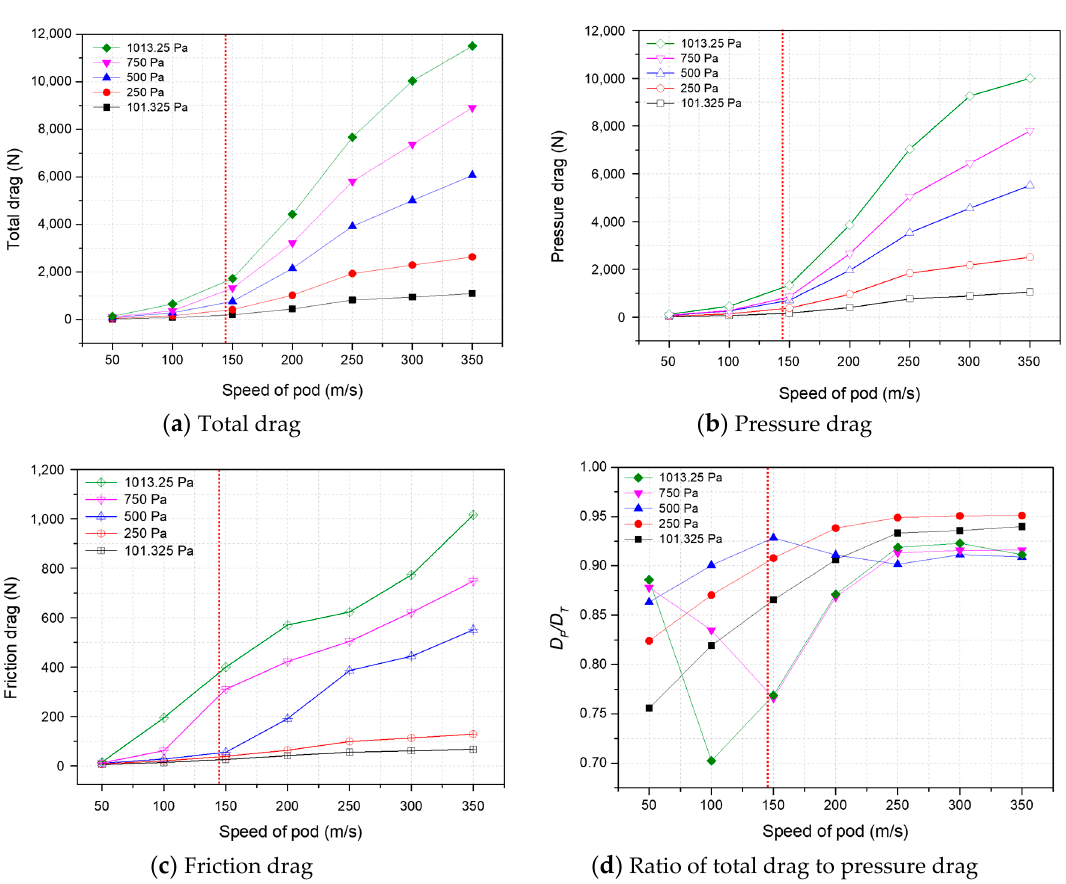
Figure 9. Effects of the tube pressure on drag.